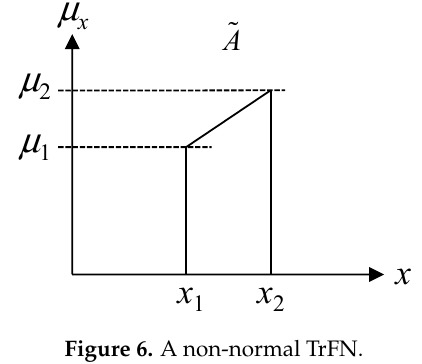
Figure 6. A non-normal TrFN.